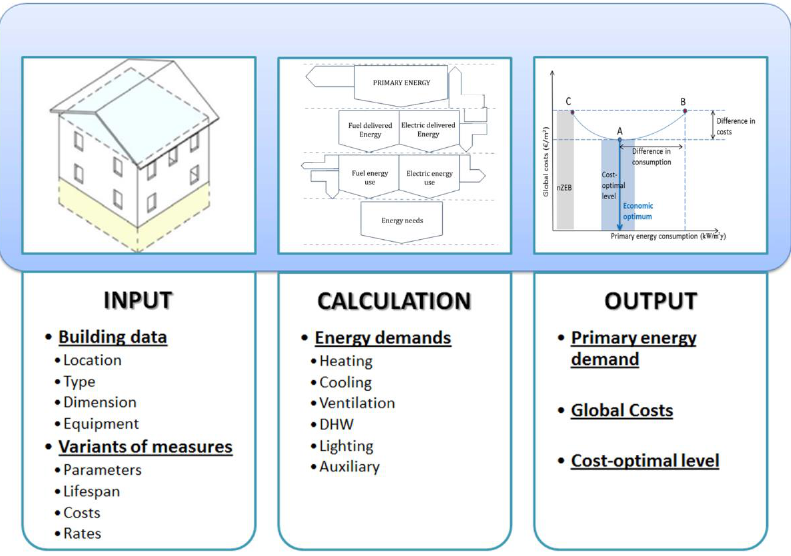
Figure 1. Steps involved in the cost-optimal methodology.